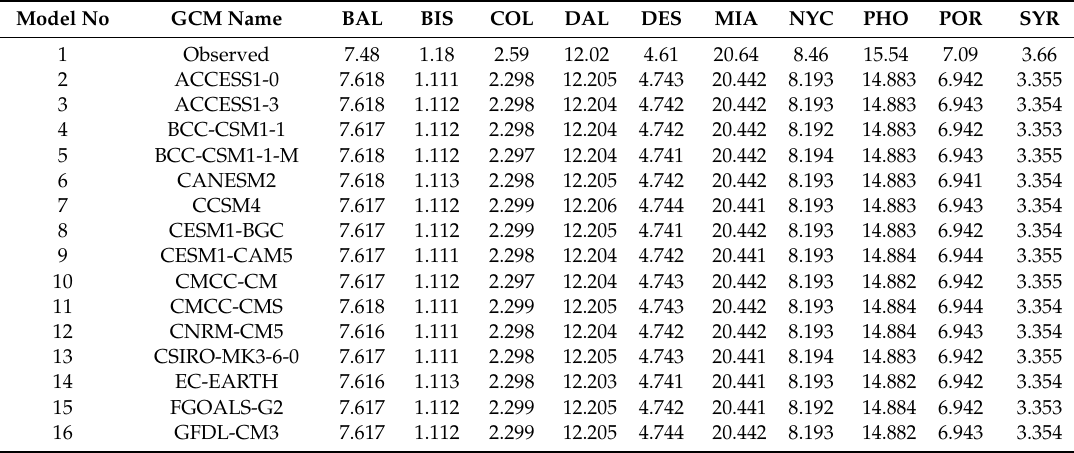
Table A2. Average observed and simulated daily minimum temperature ( ◦ C) for